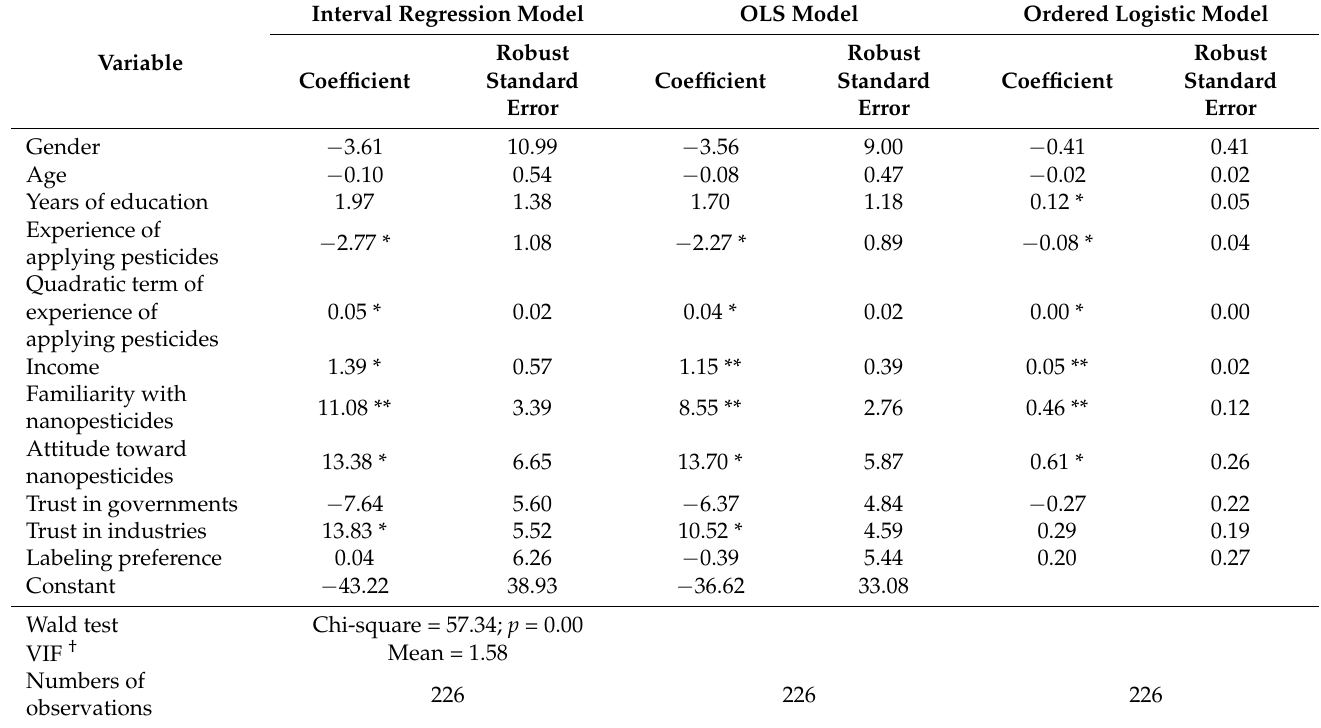
Table 2. Interval regression model for evaluating factors influencing pesticide users’ WTP for nanopesticides, and OLS and ordered logistic models for testing the robustness of the interval regression